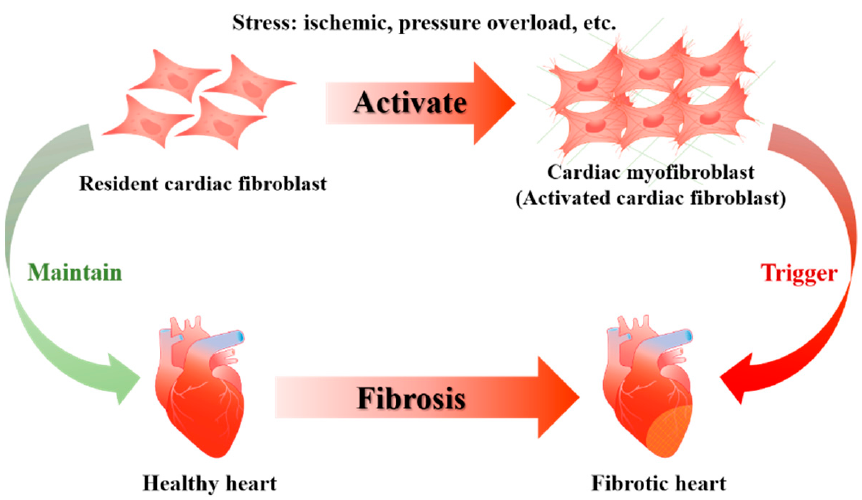
Figure 1. Cardiac fibroblasts activation and cardiac fibrosis. Activation of CFs into myofibroblasts is the cellular biological basis of cardiac fibrosis. Resident fibroblasts contribute to the maintenance of cardiac structure and homeostasis in a healthy heart. Under diverse pathologic stress and environmental stress, resident CFs in the injured heart are activated as myofibroblasts, infiltrate and proliferate in the injured area, synthesize and deposit excessive ECM, and eventually lead to the occurrence of cardiac fibrosis.